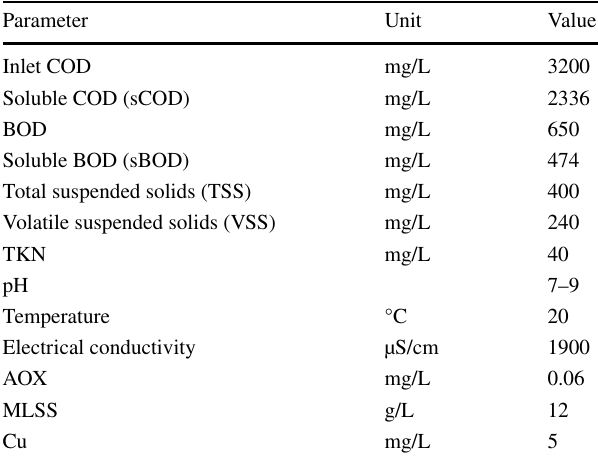
Table 1 Textile wastewater quality